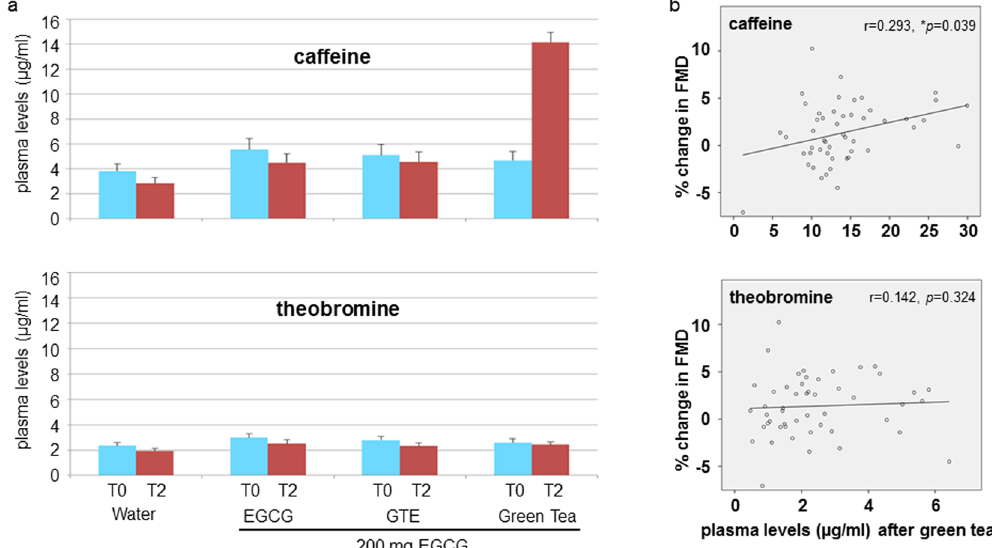
Figure 5. Caffeine but not theobromine plasma levels correlate with FMD changes after green tea consumption. Plasma levels of caffeine and theobromine before and two hours after interventions ( a ). For comparison, the scale is identical for both compounds. Data are means ± SEM from n = 50 subjects for water, EGCG, and green tea and n = 49 for GTE. Significant positive correlations between plasma levels and changes in FMD after green tea consumption were obtained for caffeine, but not for theobromine (Spearman’s) ( b ). Data are from n = 50 subjects.